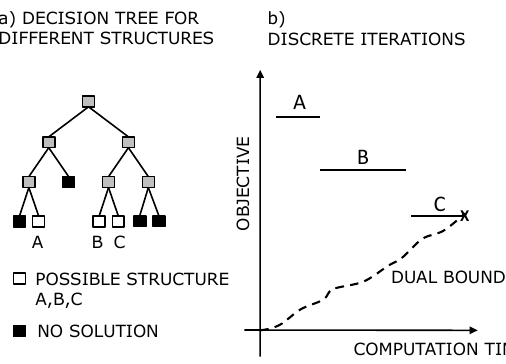
Figure 6. Decision tree ( a ) and computational process ( b ).